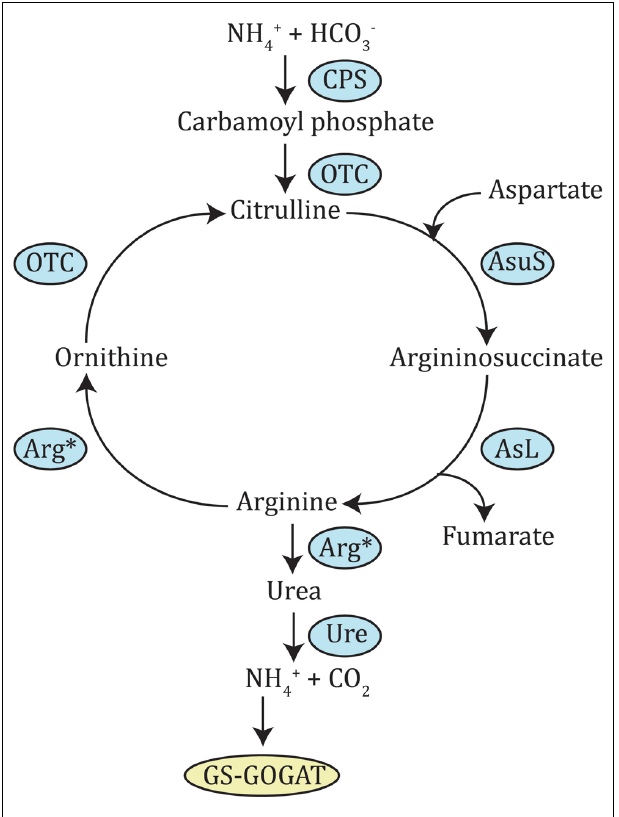
FIGURE 2 | Ornithine-urea cycle. This pathway is derived from that identified in diatoms. CPS, carbamoyl phosphate synthase; OTC, ornithine carbamoyltransferase; AsuS, argininosuccinate synthase; AsL, argininosuccinate lyase; Arg*, arginase (depicted twice, because it produces both ornithine and urea); Ure, urease.